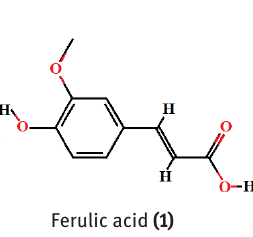
Figure 1: Bond-line formulas of Ferulic acid (1) and Chenodeoxycholic acid (2)